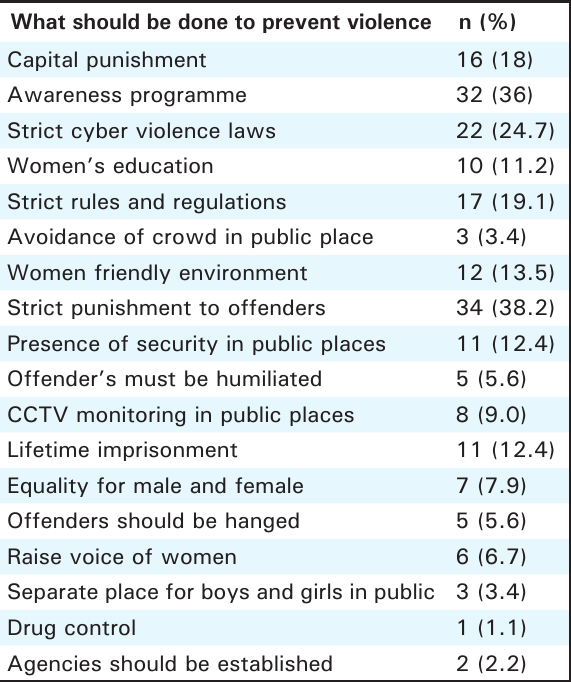
Table 3. Prevention of